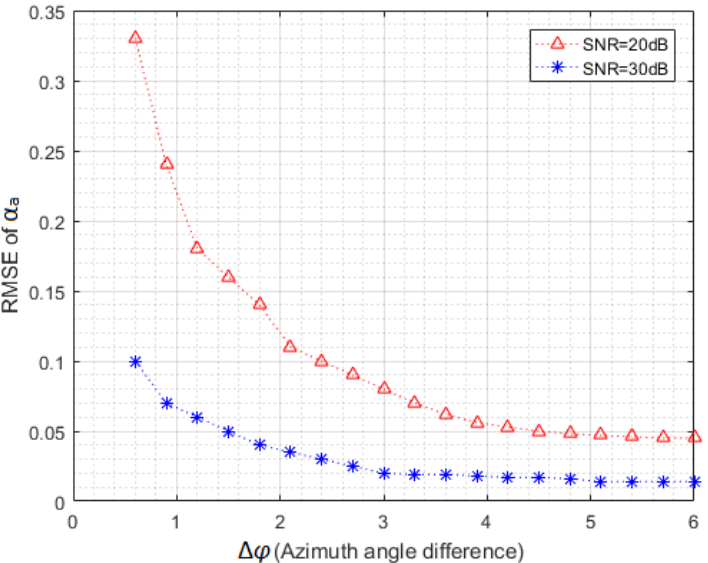
Figure 8. RMSE of α a versus ∆ ϕ = ϕ a − ϕ b for SNR = 30 dB, SNR = 20 dB, and ψ = 45 ◦ . Figure 9 represents the RMSE of α a ; in this case, SNR varies from 20 dB to 30 dB. The shape of the plot in Figure 9 is obvious; thus, the algorithm has the best perfor- mance when SNR